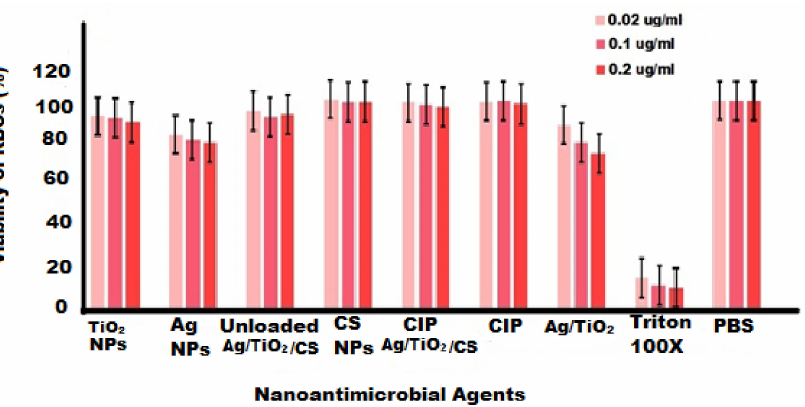
Figure 11. Hemolysis study on human red blood cells (RBCs) with nanoformulations at various concentrations, Triton 100X (PC) and PBS (NC) of